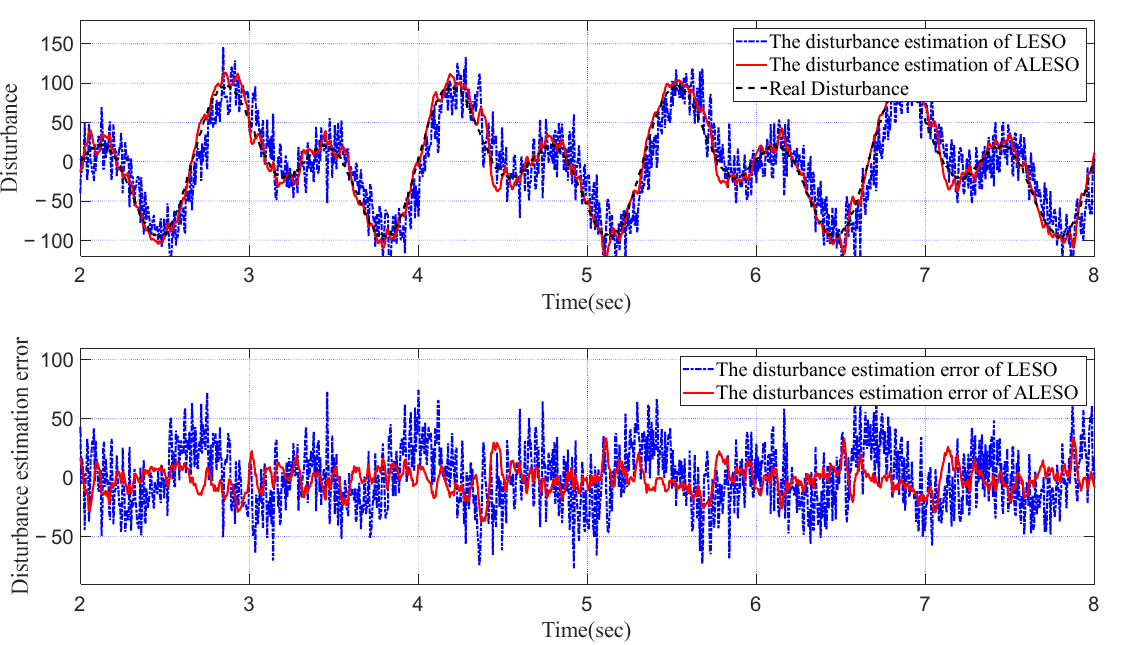
Figure 6. The disturbance estimations and errors of LESO and ALESO.